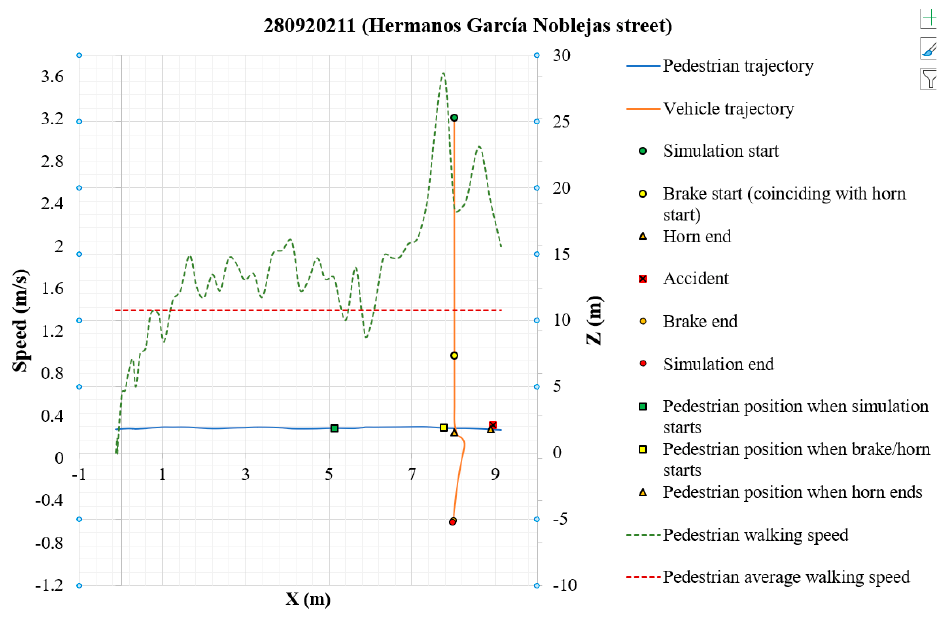
Figure 5. Trajectory and speed plots, and positioning of events for a test simulation. Through the position in X (perpendicular to the road) and Z coordinates (the vehicle is moving parallel to this axis), it is feasible to obtain the instantaneous pedestrian